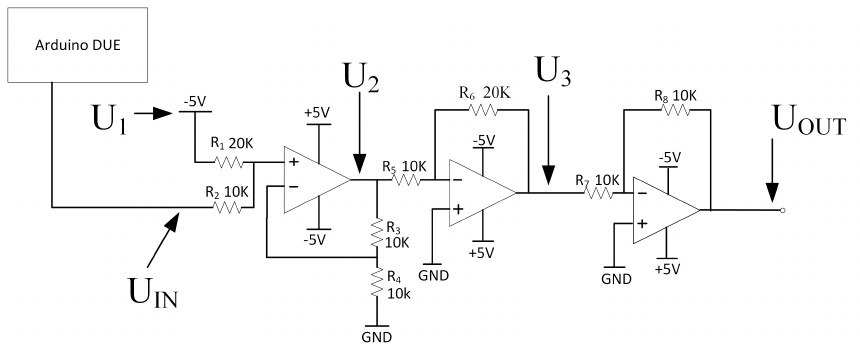
Figure 10. Subtraction circuit for conversion from {0,1} to { −